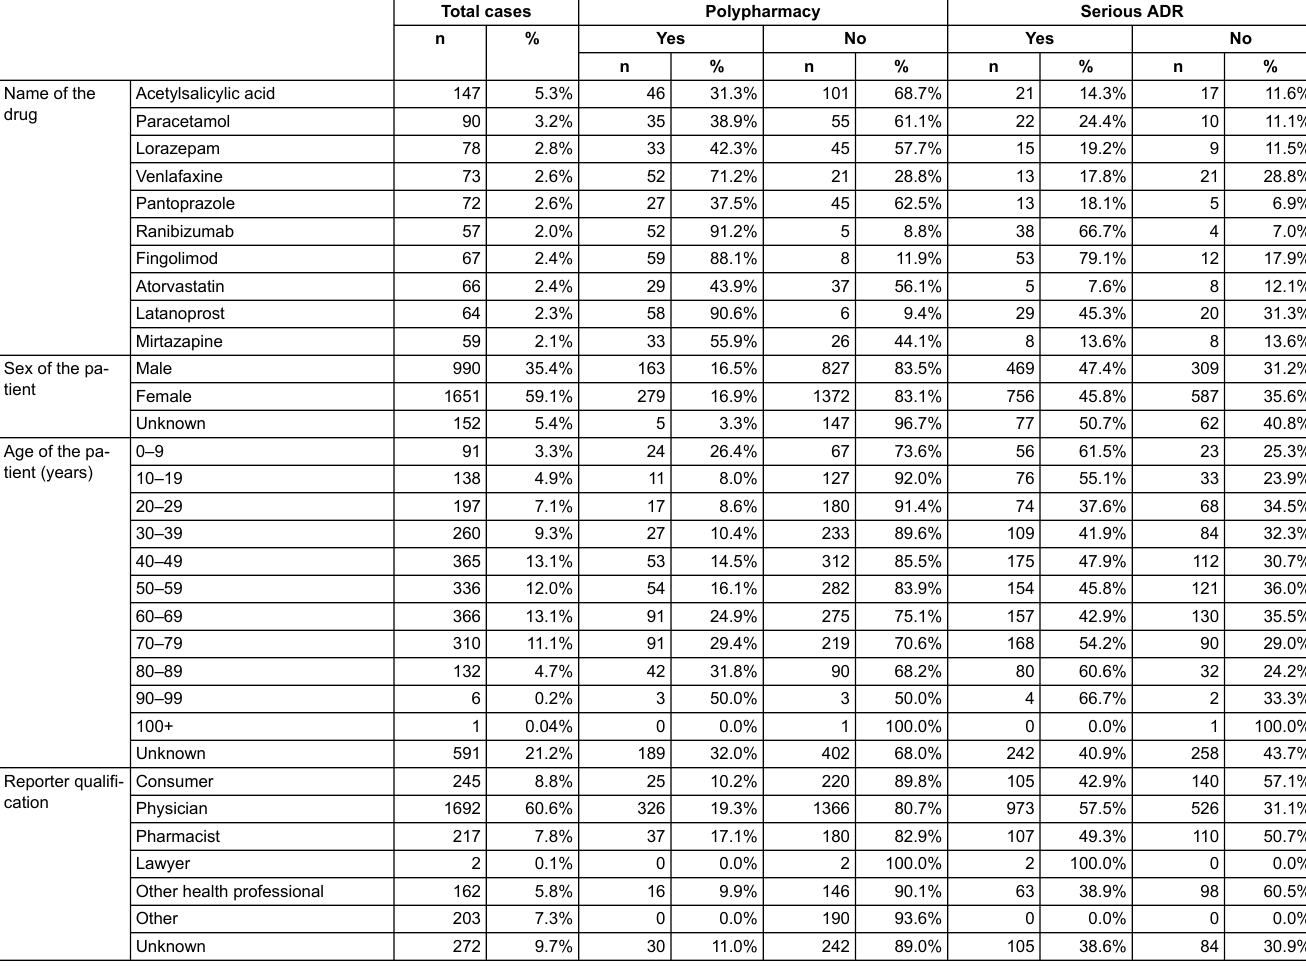
Table 1: Number and percentage of cases associated with polypharmacy and serious events, by name of implicated drug, sex and age of the patient, and qualification of the re- porting figure. Total